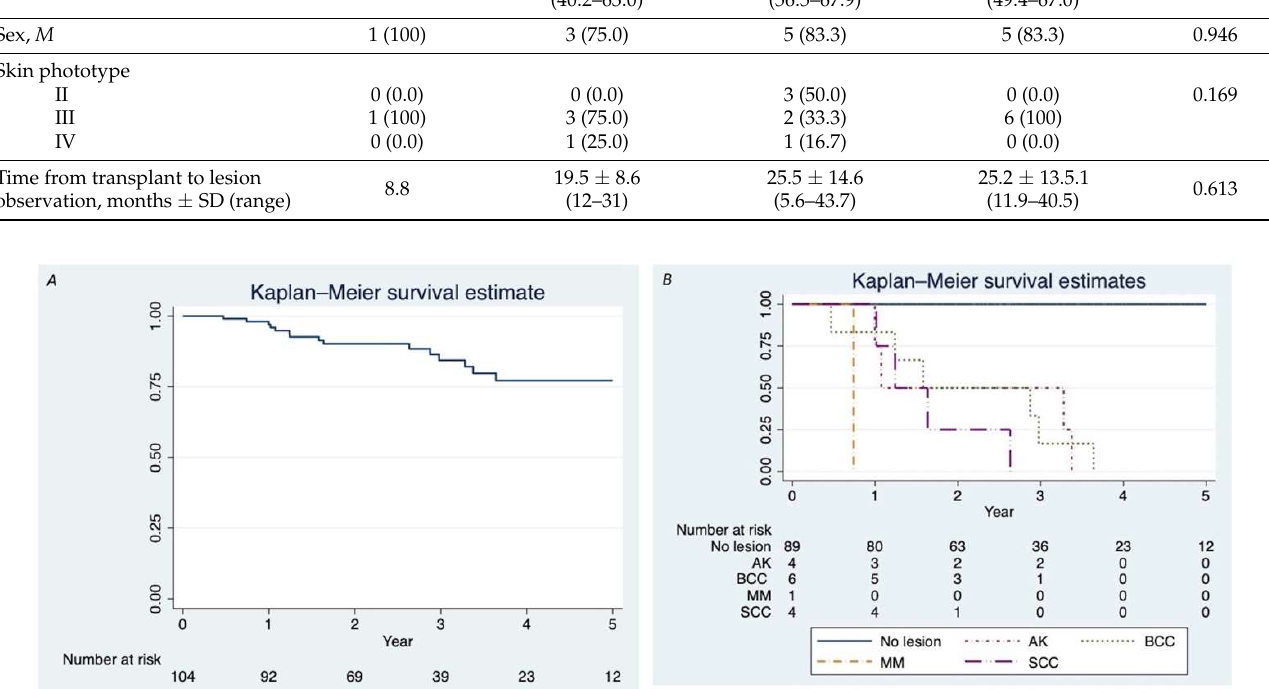
Figure 1. Disease-free survival in the LTR cohort. ( A ) Five-year disease-free overall survival represented through Kaplan–Meier curve. Actinic keratosis, melanoma, and basal and squamous cell carcinoma were all considered events. ( B ) Five-year disease-free survival for different subgroups of patients based on the type of occurring lesion represented through Kaplan–Meier curve.